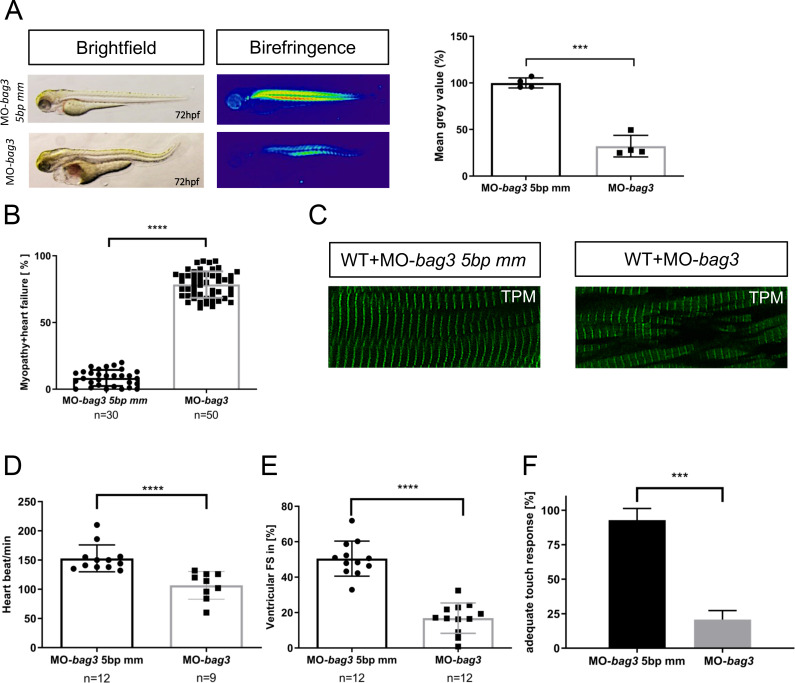
Targeted knock-down of Bag3 leads to (cardio-)myopathy in zebrafish (A) Brightfield and birefringence images of MO-bag3 and MO-bag3 5bp mm injected embryos developed (cardio-)myopathy phenotype at 72 hpf. The densitometric analysis of birefringence supports the presence of myopathy phenotype only in bag3 morphants. Representative samples are shown (n = 4, P = 0.0003 determined using two tailed t-test). (B)
bag3 splice MO injected embryos develop (cardio-)myopathy phenotype (78.42±9.88%) whereas control-injected embryos developed no pathological phenotype (78.42±9.89%) (N = 3, n = 30/50 mean± SD P<0.0001 determined using two-tailed t-tests). (C) Tropomyosin immunostaining of MO-bag3 and MO-bag3 5bp mm embryos at 72 hpf shows that embryos injected with Bag3 splice MO develop muscle fiber disruptions. (D) Heart rate quantification of bag3 morphants reveals impairments at 72 hpf (N = 3, n = 9/12, P = 0.6026. HR 5bp-mismatch-MO injected embryos: 153±22.98 heart beat/min; HR bag3 morphants: 106±23.58 heart beat/min; mean ± S.D. P<0.0001 determined using two-tailed t-tests). (E) FS of bag3 morphant ventricles at 72 hpf is significantly reduced (16,88±8.56%), compared to MO-bag3 5bp mm injected embryos (FS: 50.48±9.90%) (N = 3, n = 12; Mean± SD P<0.0001 determined using two-tailed t-tests). (F) Touch evoked assay reveals significant reduction in responsiveness upon mechanical stimulus for bag3 morphants (20.78±4.46%) and not for 5bp-mismatch-MO injected embryos (92.78±4.40%) (N = 3, n = 40, mean ± S.D. P = 0.0005, determined using two-tailed t-tests).